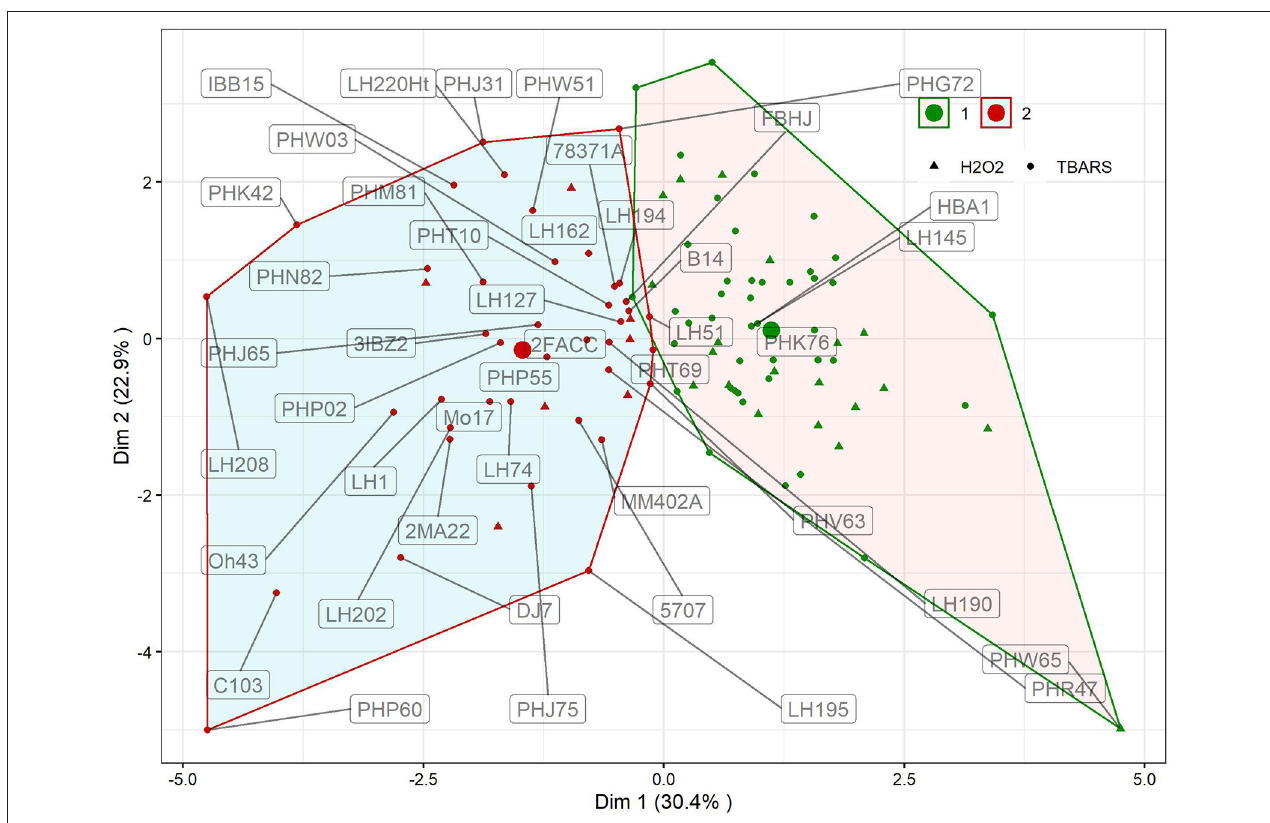
FIGURE 3 | Results of K-means clustering of genotypic means using trait fold-change values of GPOD, PROT, TBARS, proline, H 2 O 2, and CWC in WW compared to CO. Inbred designations are given for all inbreds belonging to the cluster 2 and TBARS > H 2 O 2 group, along with inbreds surrounding the centroid in cluster 1 and the most extrema phenotype in cluster 1 (PHW65). Large dots show centroid of each